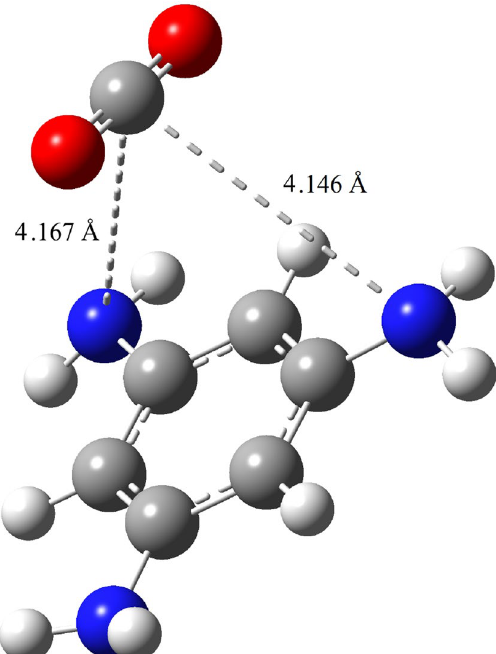
Figure 1. Geometry-optimized structure of CO 2 gas in the presence of 1,3,5-TAB